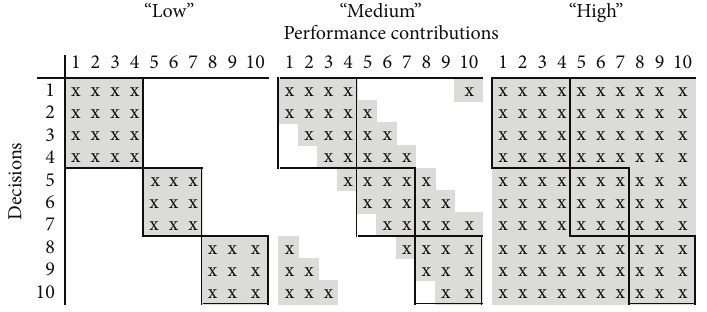
Figure 1: Interdependence